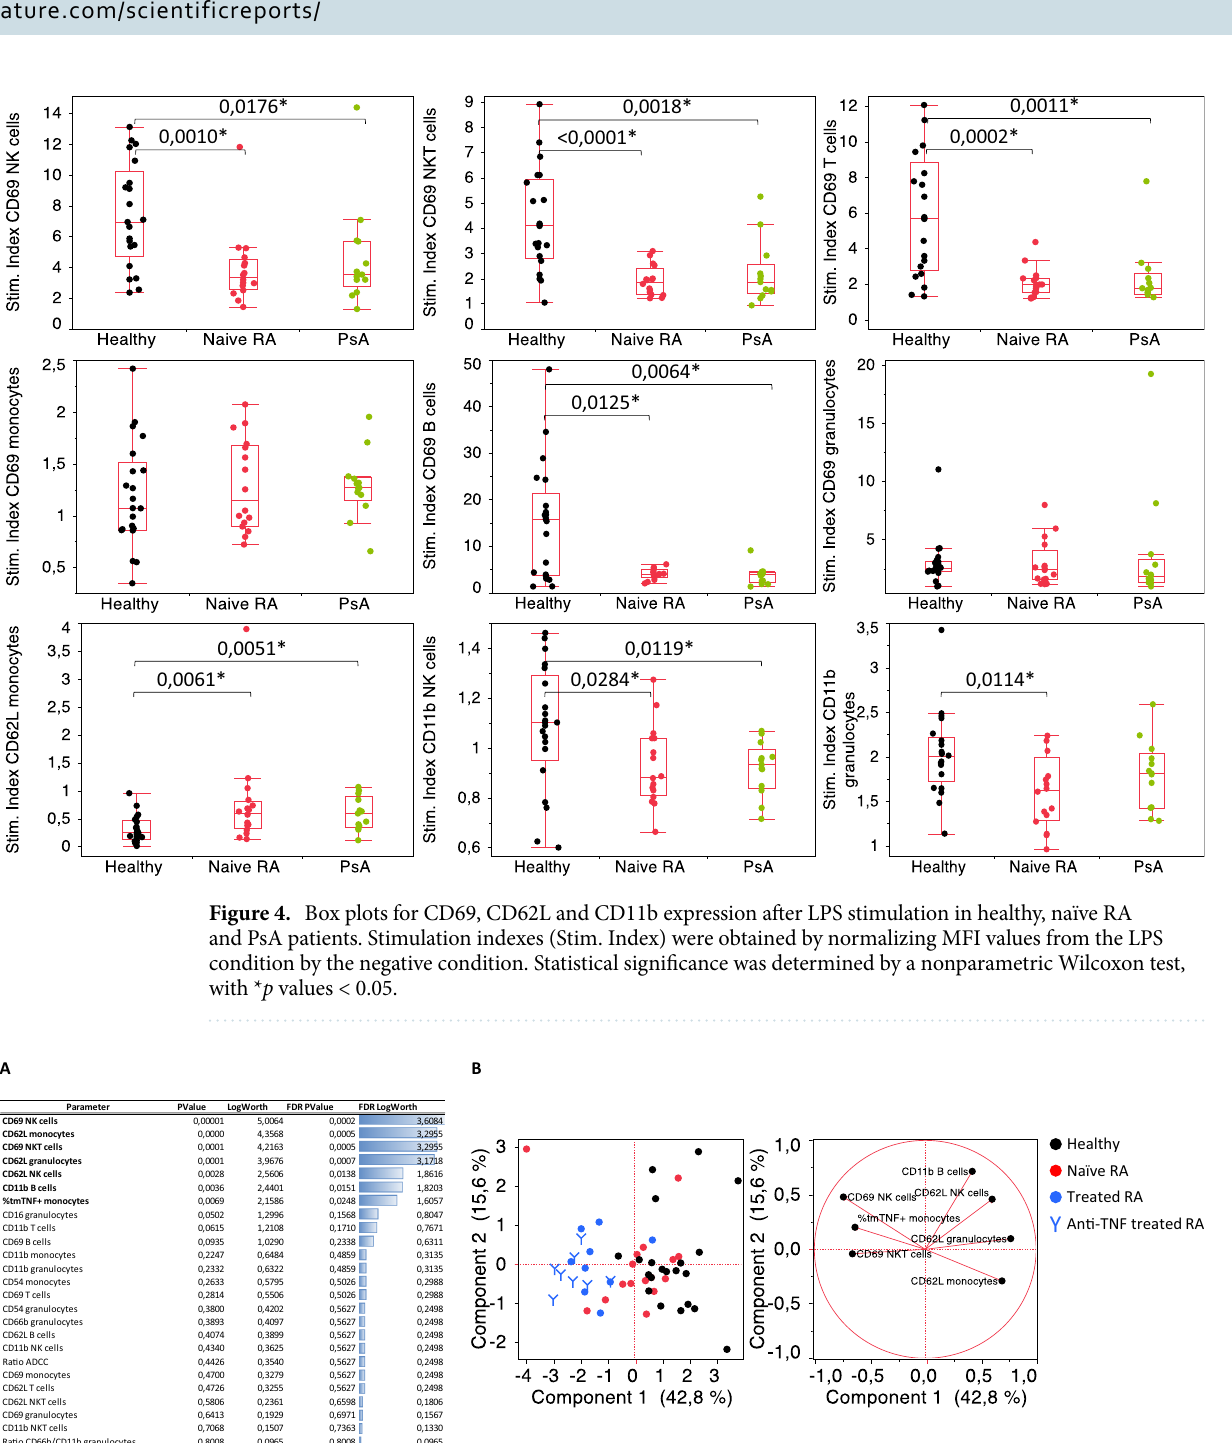
Figure 5. Multivariate analysis of all parameters considered for the LPS+IFX condition. healthy donors, naïve and treated RA patients in the LPS+IFX condition. ( A ) Response screen of Stimulation Indexes of immune cell markers. Stimulation Indexes were obtained by normalizing LPS+IFX MFI values by LPS MFIs. ( B ) Principal component analysis were only most discriminant features having a p < 0.05 were included in the